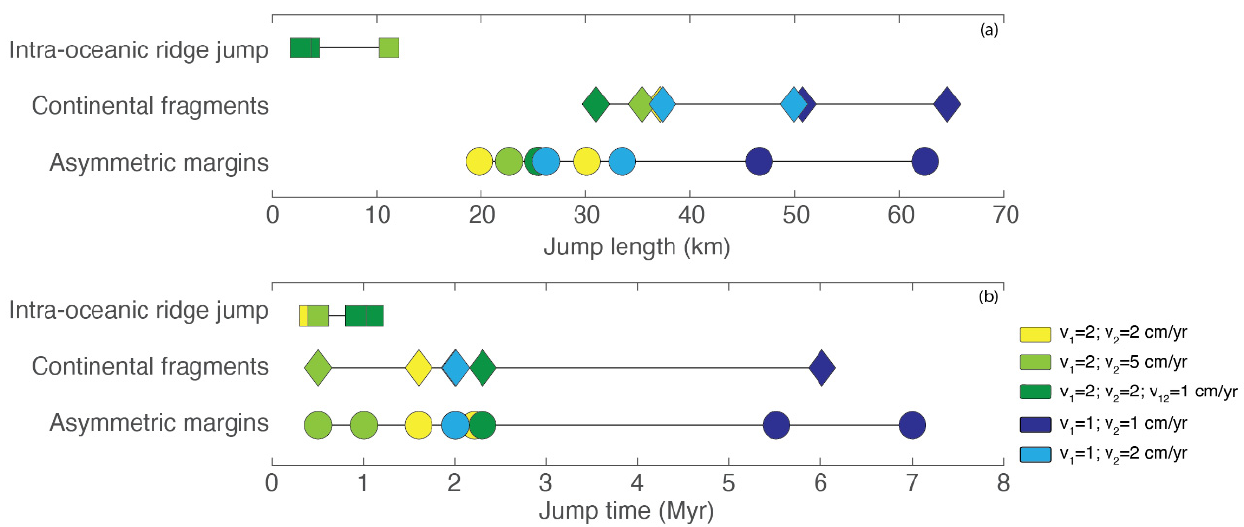
Figure 8. Plots showing the range of values for ( a ) length and ( b ) time of the rift/ridge jumps in all models as a function of their resulting scenarios. Jump time is computed from the moment extension phase 2 starts. Colours show the different extension velocities.